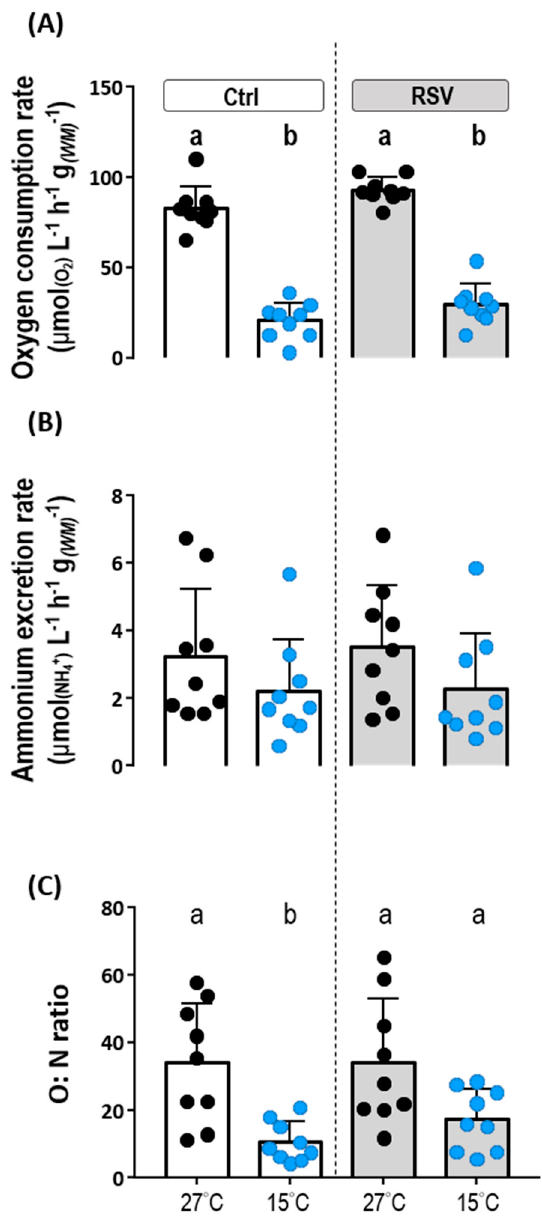
Figure 3. E ff ects of Ctrl and RSV-diets on oxygen consumption, ammonium extraction rate and O:N ratio at 27 ◦ C and 15 ◦ C. Metabolic rates were measured in fish fed with the Ctrl and RSV-diet by oxygen consumption of intact juvenile tilapia under 27 ◦ C and 15 ◦ C conditions ( A ). NH 4 + excretion rates were determined for fish fed with Ctrl and RSV-diets according to NH 4 + concentrations in bath water of intact juvenile tilapia under 27 ◦ C and 15 ◦ C conditions ( B ). ( C ) O:N ratios were calculated from oxygen consumption rate and NH 4 + excretion rate shown in ( A , B ). Black dots and white columns represent the Ctrl-diet group at 27 ◦ C. Blue dots and white columns represent the Ctrl-diet group at 15 ◦ C. Black dots and gray columns represent the RSV-diet group at 27 ◦ C. Blue dots and gray columns represent the RSV-diet group at 15 ◦ C. Data are presented as mean ± SD ( n = 8 or 9). Di ff erent letters indicate significant di ff erences ( p < 0.05) among di ff erent groups (Two-way ANOVA and Tukey’s